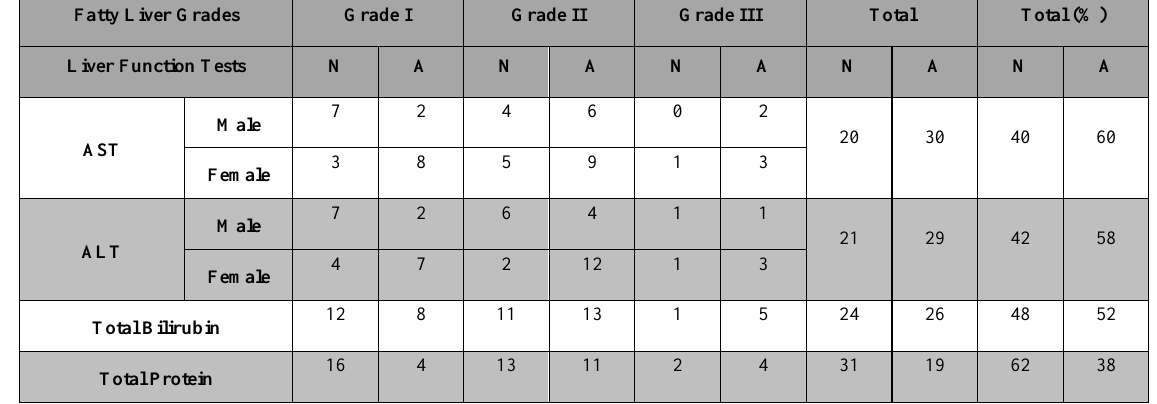
Table 4. Distribution of patients showing abnormal liver function tests in